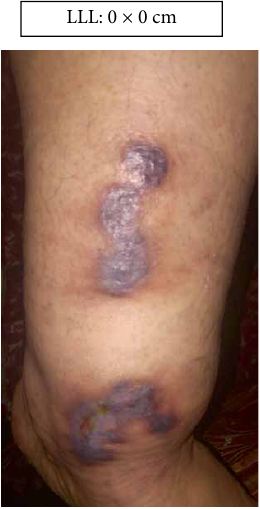
Figure 14: Week 4 . Lower left limb.